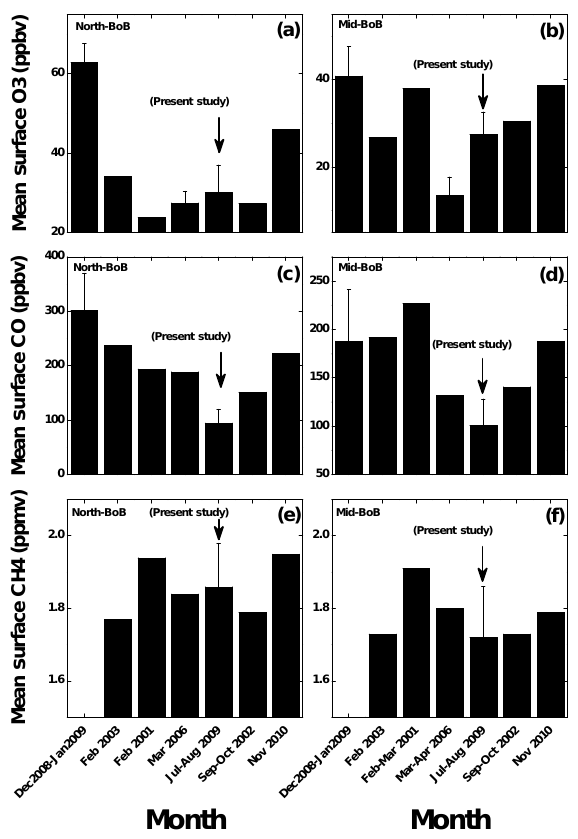
Figure 12. Seasonal variation in average O 3 , CO, and CH 4 mixing ratios over ( a , c , e ) northern BoB and ( b , d , f ) central BoB. Except for July–August 2009 (present study period), all average values are obtained from the literature (David et al., 2011; Lal et al., 2007, 2006; Nair et al., 2011; Srivastava et al., 2012; Sahu et al., 2006; and Mallik et al., 2013). Error bars show standard deviations for respective study periods. For any points for which high-resolution measurements are not available, standard deviations are not